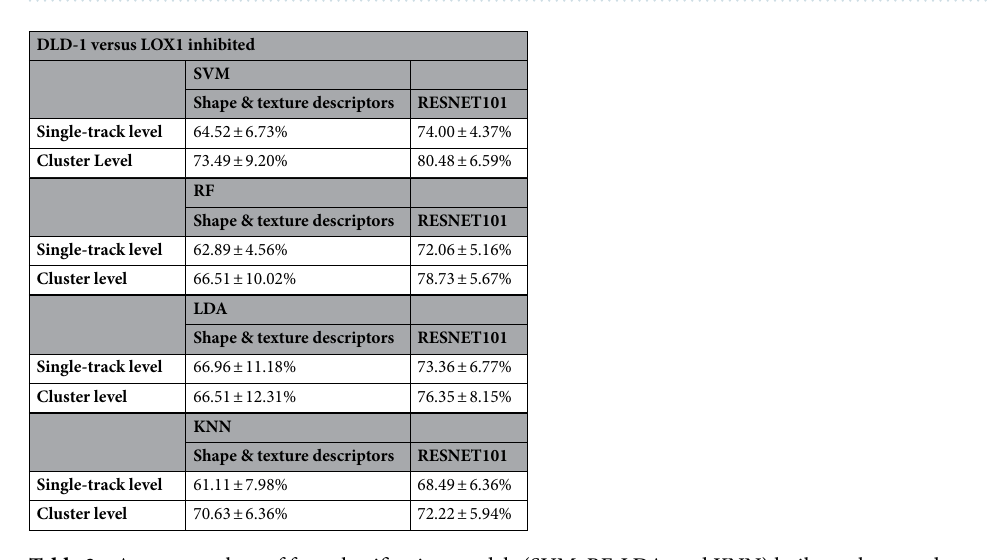
Table 2. Accuracy values of four classification models (SVM, RF, LDA, and KNN) built on shape and texture descriptors, compared with the results obtained using RESNET101 transfer learning descriptors.